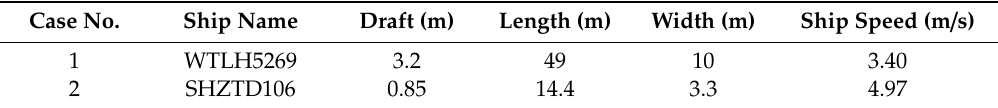
Table 1. Properties of the two ship passages.